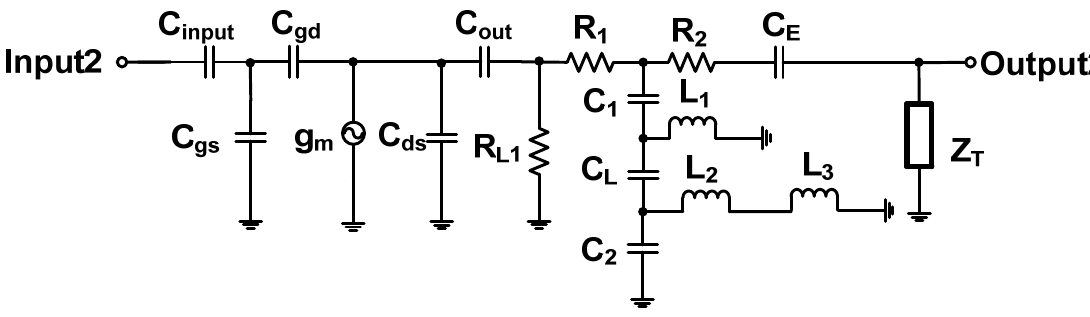
Figure 4. Equivalent circuit model of the HVPA with post ‐ linearizer.